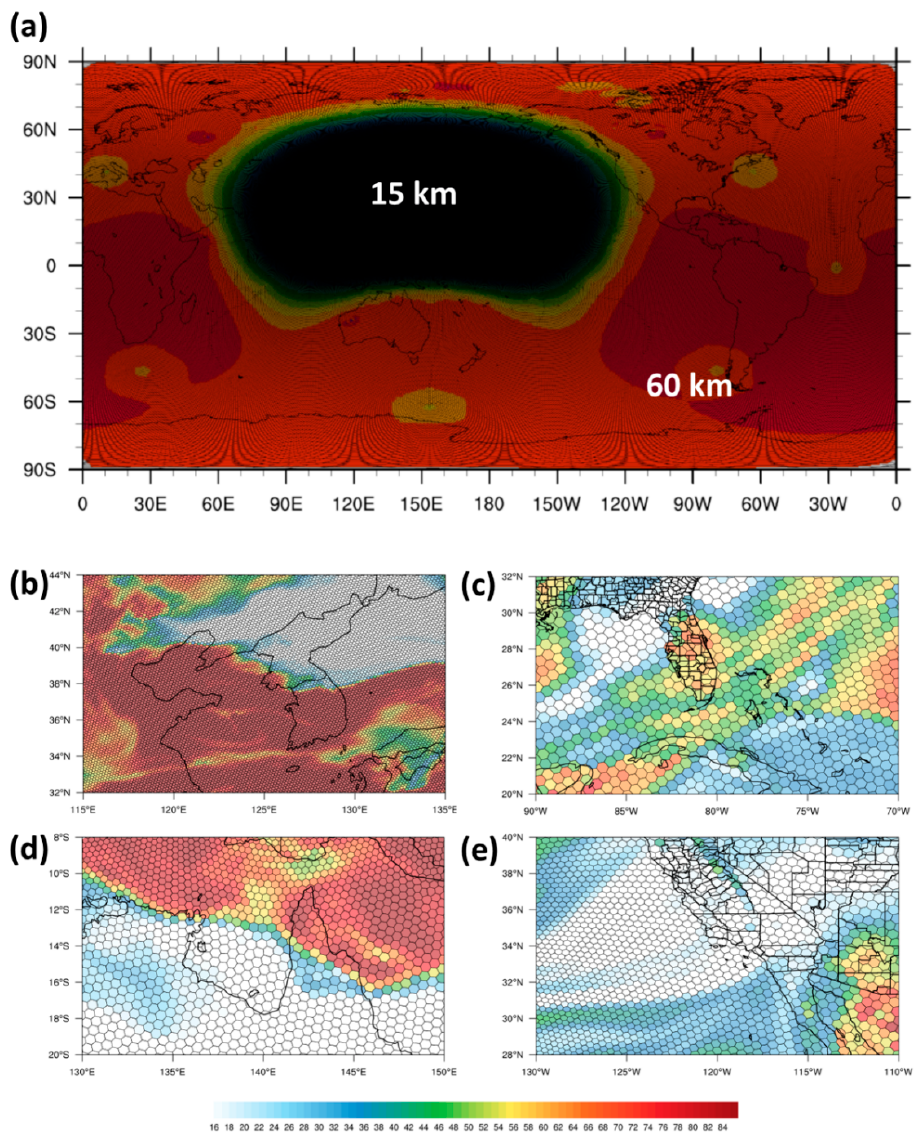
Figure 1. MPAS variable-resolution meshes: ( a ) 60–15 km variable resolution settings. Here, the red-orange area has a 60 km quasi-uniform resolution while the blue area has a 15 km resolution. The yellow-green area has smooth conforming meshes between 60 and 15 km resolution. Examples of ( b ) a 15 km resolution area, ( c ) a 60 km resolution area, and ( d , e ) transient meshes are shown. The shading of ( b – e ) indicates relative